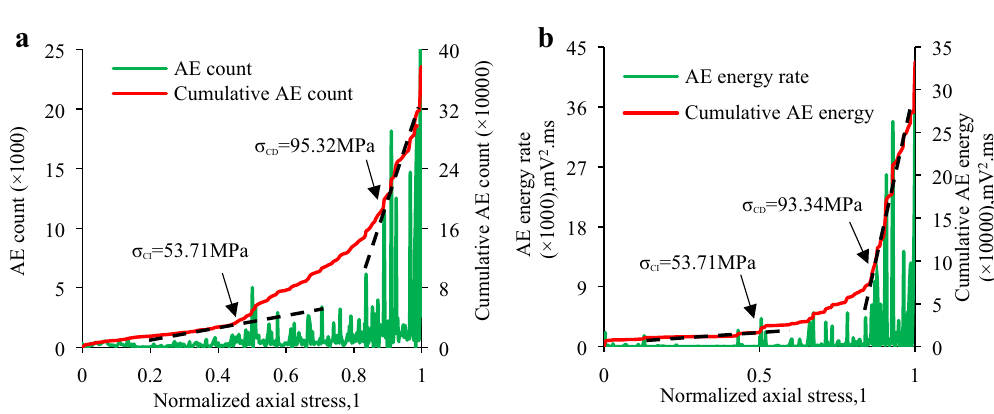
Figure 10. CI and CD thresholds of granite specimen in Test Case 2–2 ( θ = 5°) determined by AE energy and AE count: ( a ) CI and CD thresholds determined by AE count; ( b ) CI and CD thresholds determined by AE energy.